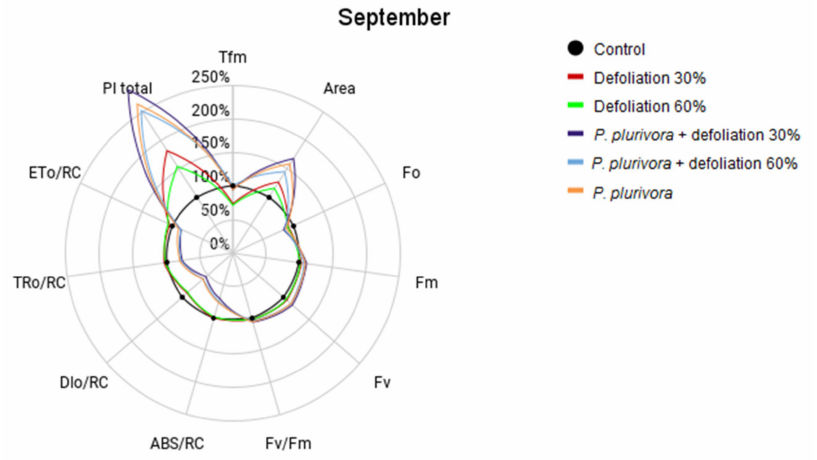
Figure 4. Comparison of chlorophyll fluorescence parameters in different treatments in September. Parameters: PI total—the total performance index of photosystem II, Tfm—the time at which the maximum fluorescence value was reached, Fo—the initial fluorescence representing the emission by excited chlorophyll molecules in the antenna structure of the photosystem II, Fm—the maximum fluorescence value, Fv—variable fluorescence, Fv/Fm—maximum photochemical quantum yield of PSII, Area—the area across the fluorescence curve between Fo and Fm, ABS/RC—absorption flux of antenna Chls per RC (RC—reaction center), TR0/RC—trapped energy flux per RC, ET0/RC—electron transport flux per RC, DI0/RC—total energy dissipated per reaction